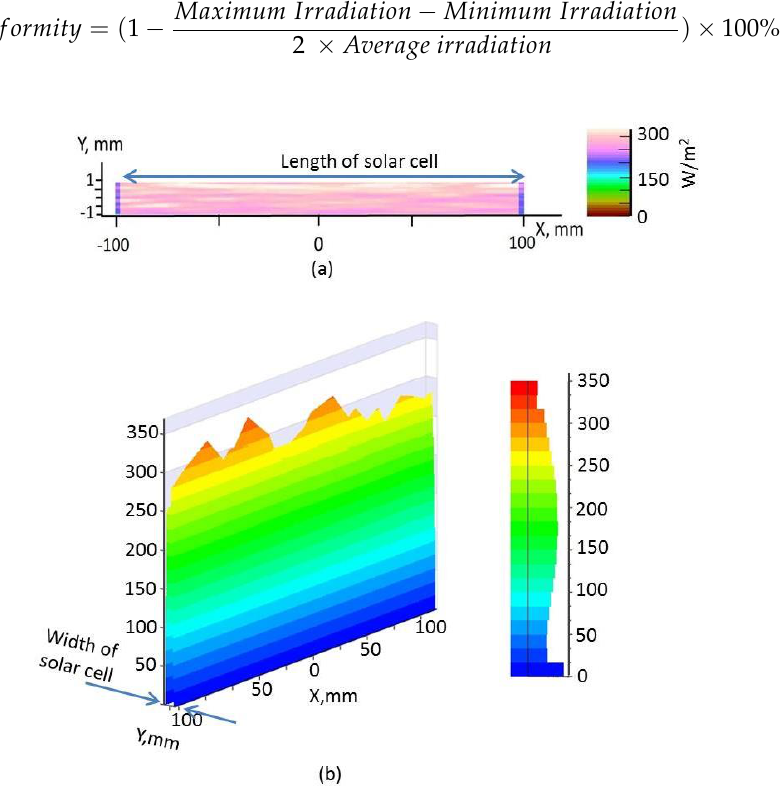
Figure 13. ( a ) A 2D irradiance distributions on the exit port of P-CPC; and ( b ) a 3D irradiance distributions on the exit port of P-CPC.